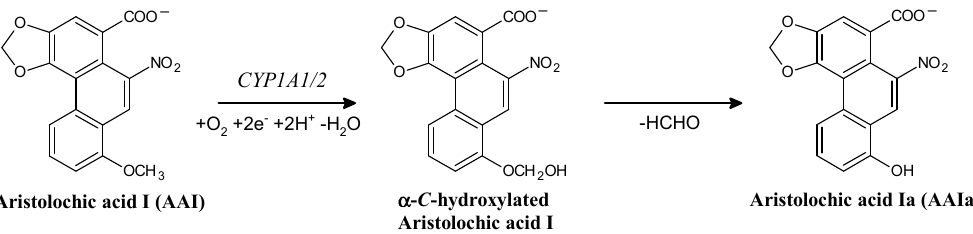
Figure 4. The CYP-mediated O -demethylation of AAI to AAIa.